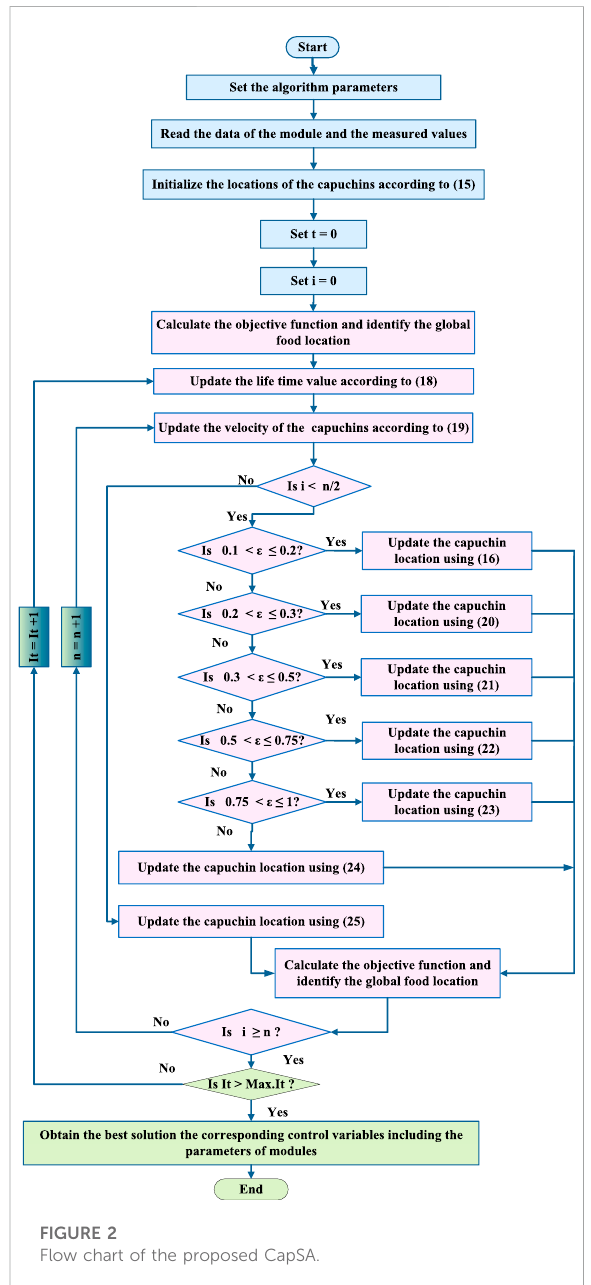
FIGURE 2 Flow chart of the proposed